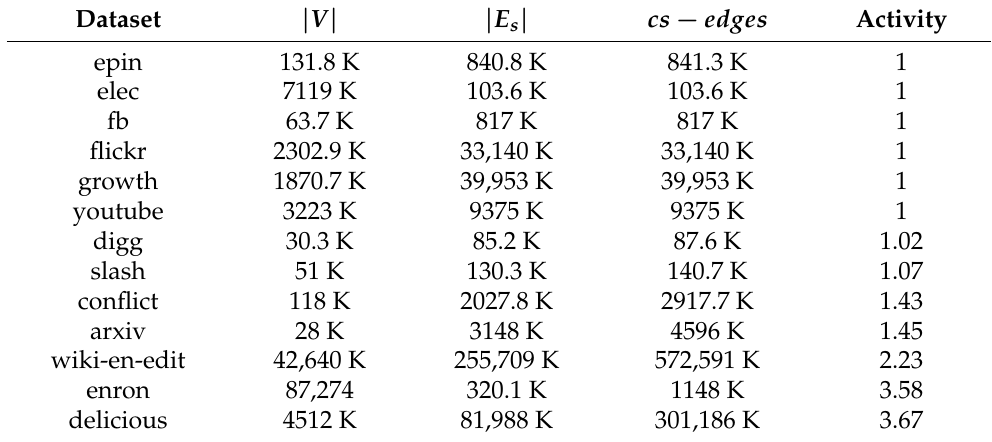
Table 1. Koblenz collection graph